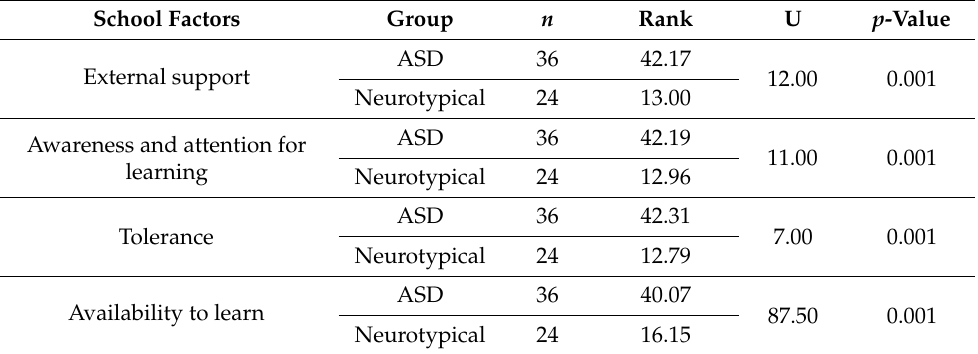
Table 3. Comparison of the scores obtained by children with ASD and neurotypical children in the category “school